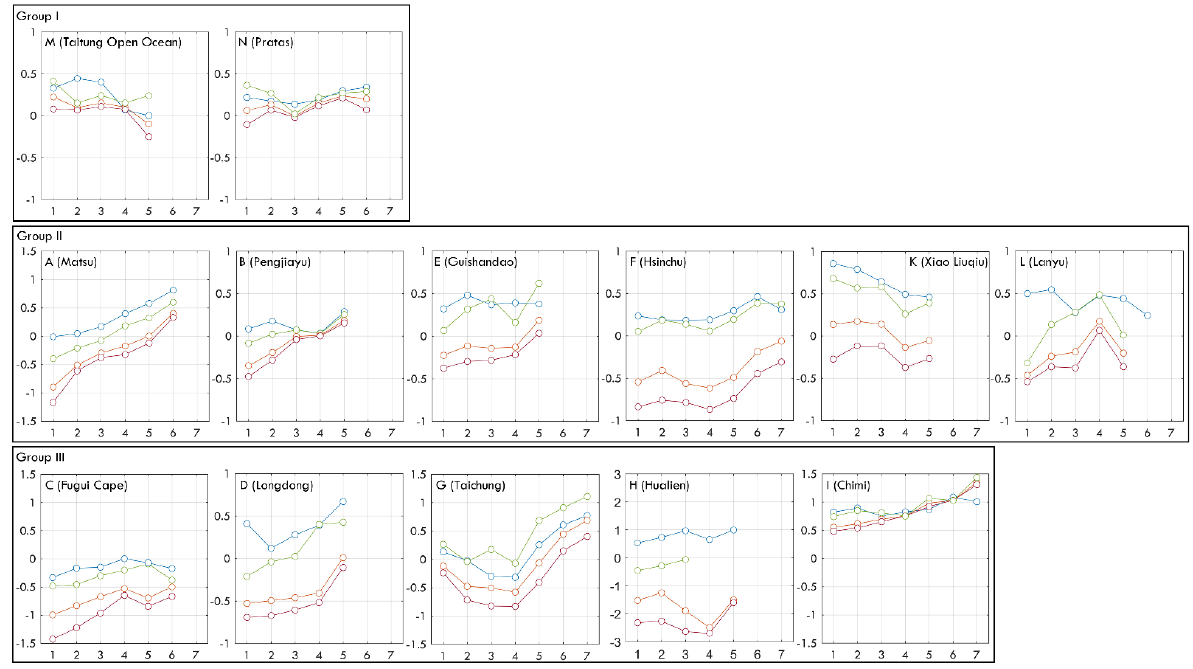
Figure 10. The effect of wind speed on ocean near-surface temperature. The horizontal axis is the Beaufort wind force scale, where one represents a wind speed of 0.3 – 1.5 m/s and seven represents a wind speed of 13.9 – 17.1 m/s; the vertical axis is the bias of the bulk SST minus the skin SST (°C). The blue line represents the nighttime, the orange line is the daytime, the green line is the shortwave radiation less than 500 W/m 2 , and the red line is the shortwave radiation higher than 500 W/m 2